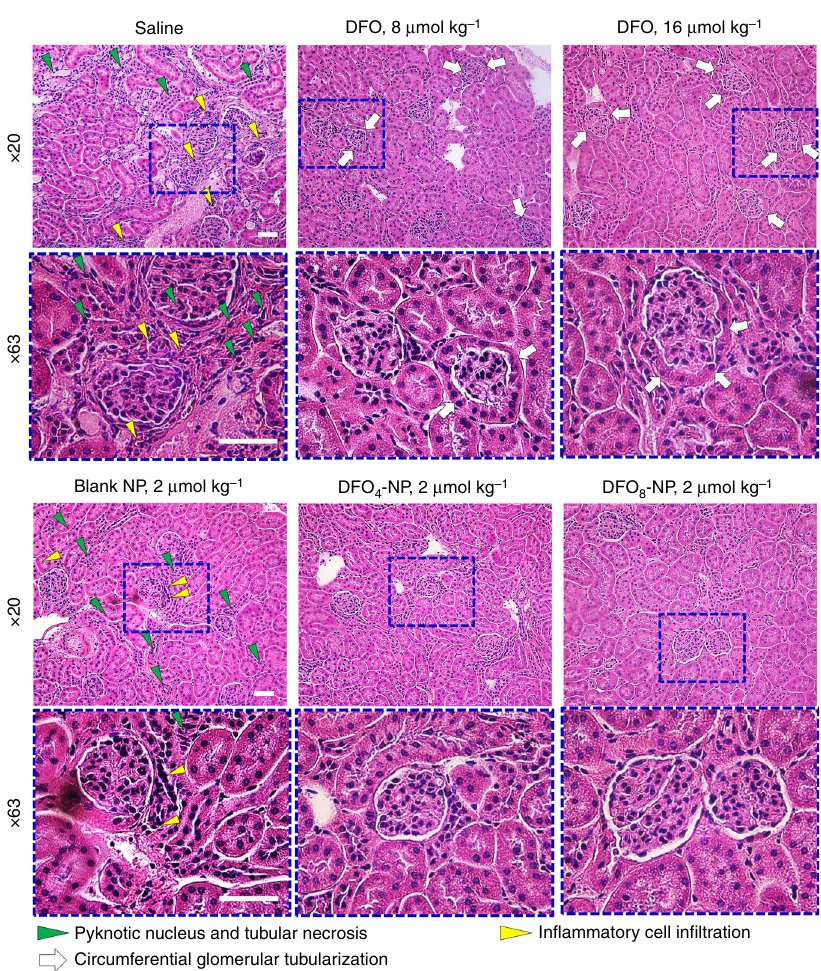
Fig. 4 Nephrotoxicity in dietary iron overload mice: H&E-stained sections of renal cortex in mice following 5 days daily treatments of saline, DFO, and DFO- NPs via SC injection. The regions in the blue boxes are magni fi ed at ×63 to show the difference in the preservation of the renal corpuscle architecture. Scale bars: 50 µ